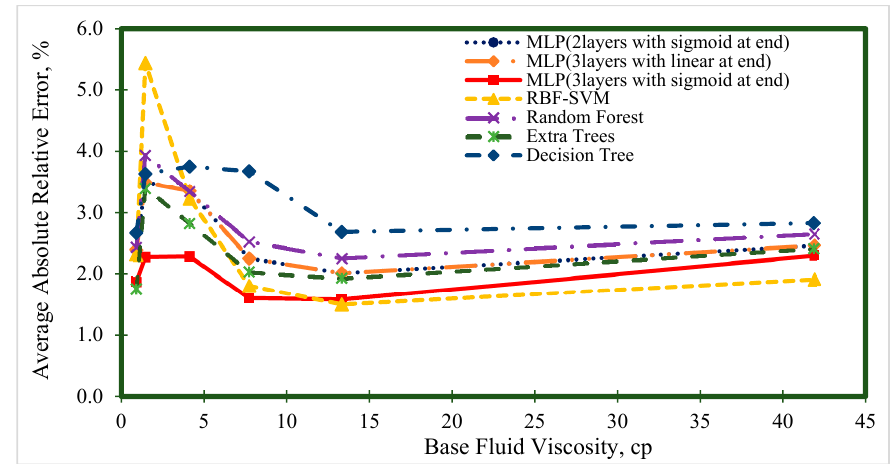
Figure 10. Average absolute relative error at different base fluid viscosity ranges for prediction of the viscosity of nanofluids. Nanomaterials 2020 , 10 , x FOR PEER REVIEW